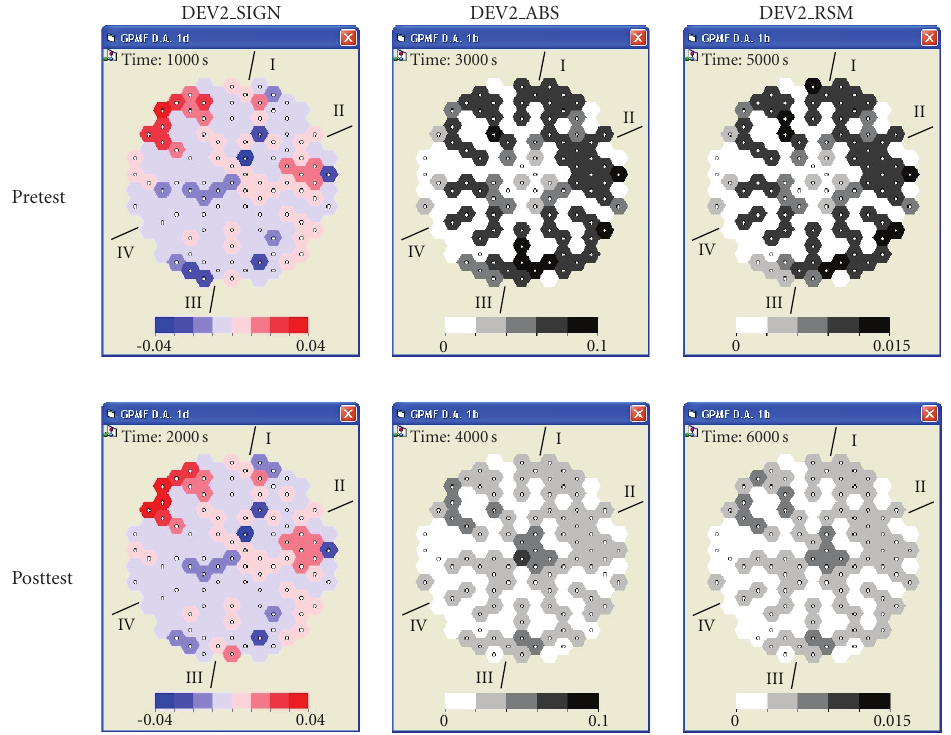
Figure 12: Maps of DEV2